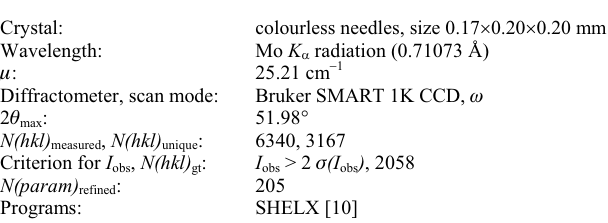
Table 1. Data collection and handling. Table 2. Atomic coordinates and displacement parameters (in Å 2 )